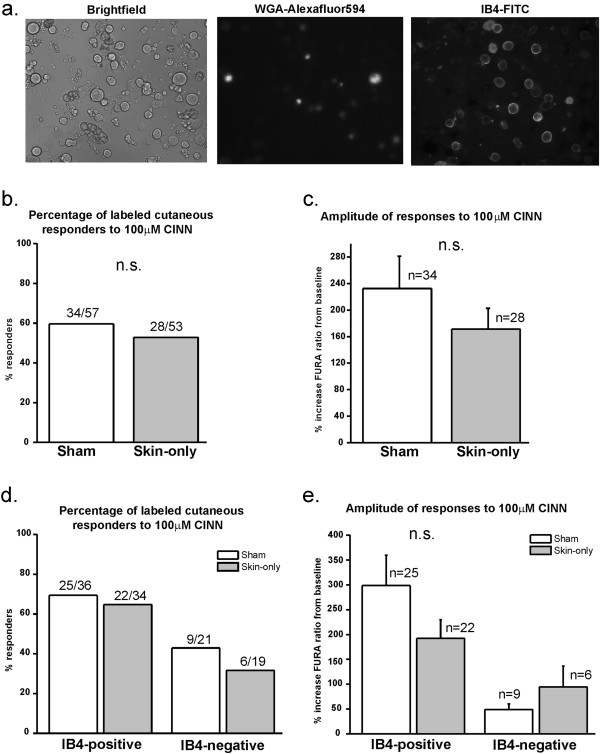
TRPA1 is not functionally up-regulated in retrogradely labeled cutaneous neurons from glabrous plantar skin following skin-only incision injury. a. Representative brightfield (left), WGA-Alexafluor594 retrograde label (middle), and IB4-FITC (right) images of ipsilateral lumbar 3–5 neurons from incised mice with retrograde label and IB4 staining (20x objective). Neurons that brightly fluoresced with Alexafluor594 at least 2-times the standard deviation above autofluorescence were considered to be positively stained for the retrograde tracer and recorded. IB4-positive neurons were defined by a halo of FITC labeling around the entire perimeter of the somata of small-diameter (<27 μm) neurons. b. Percentage of cutaneous neurons responding to CINN. There is no difference in the percentage of labeled WT neurons responding to 100μM CINN from skin-only incised and sham mice. Neurons were pooled from 3 mice per group. c. Amplitude of responses of cutaneous neurons to CINN. Ipsilateral retrograde-labeled neurons from skin-only incised WT mice respond with the same amplitude of intracellular increase to 100μM CINN as neurons from sham mice. Same neurons as those in Figure 4b. d. Percentage of cutaneous neurons responding to CINN defined by IB4 staining. There is no difference in percentage of labeled neurons responding to 100μM CINN defined by IB4 binding. Same neurons as those in Figure 4b. e. Amplitude of responses of cutaneous neurons responding to CINN defined by IB4 staining. There was no difference in amplitude of responses to 100μM CINN in labeled neurons defined by IB4 staining. Same neurons as those in Figure 4b.